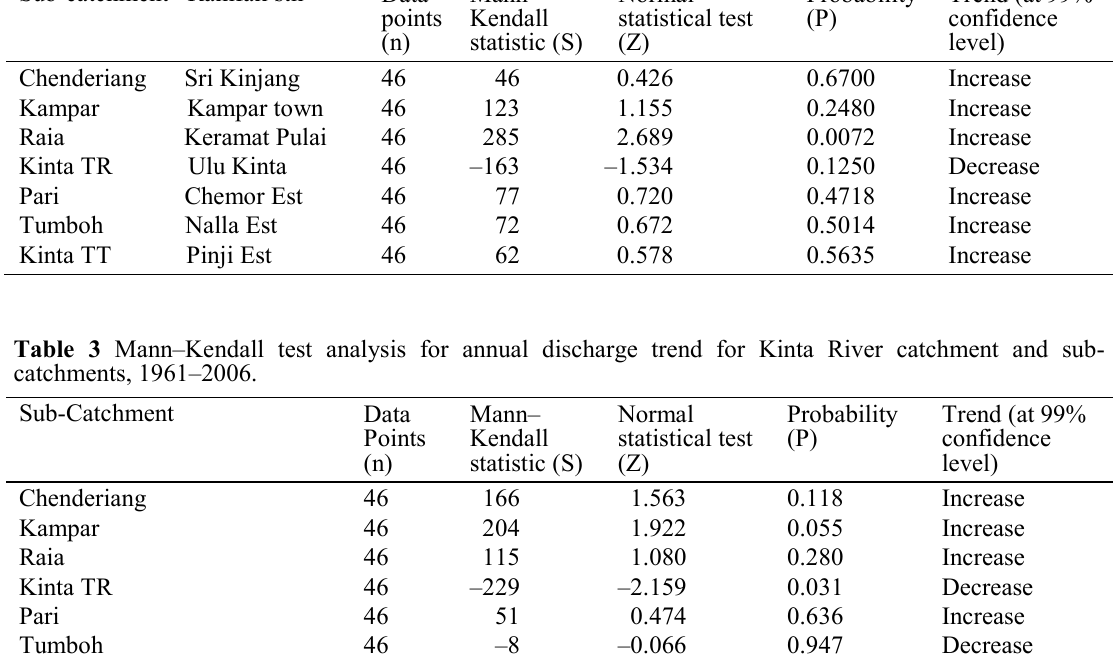
Table 2 Mann–Kendall test analysis for rainfall trend in the Kinta River catchment and sub-catchments, 1961–2006. Sub-catchment Rainfall stn